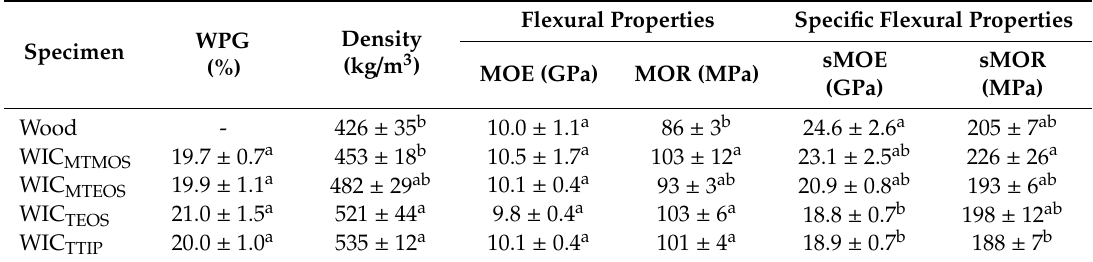
Table 1. Density and flexural properties of wood and wood-inorganic